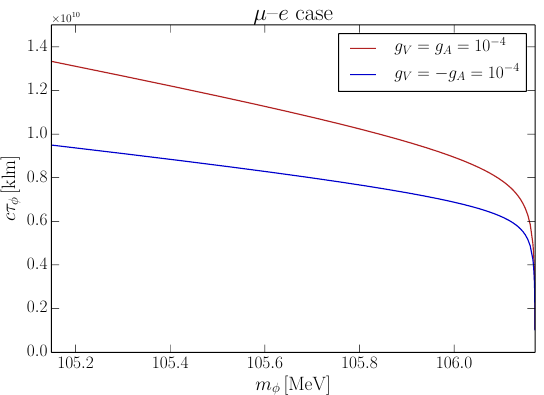
Figure 2 . The decay length cτ φ of φ in the µ – e case. The red line corresponds to g V = g A = 10 − 4 and the blue line to g V = − g A = 10 − 4 . Note that the parameter region | g V | ' | g A | is preferred from the electron g − 2